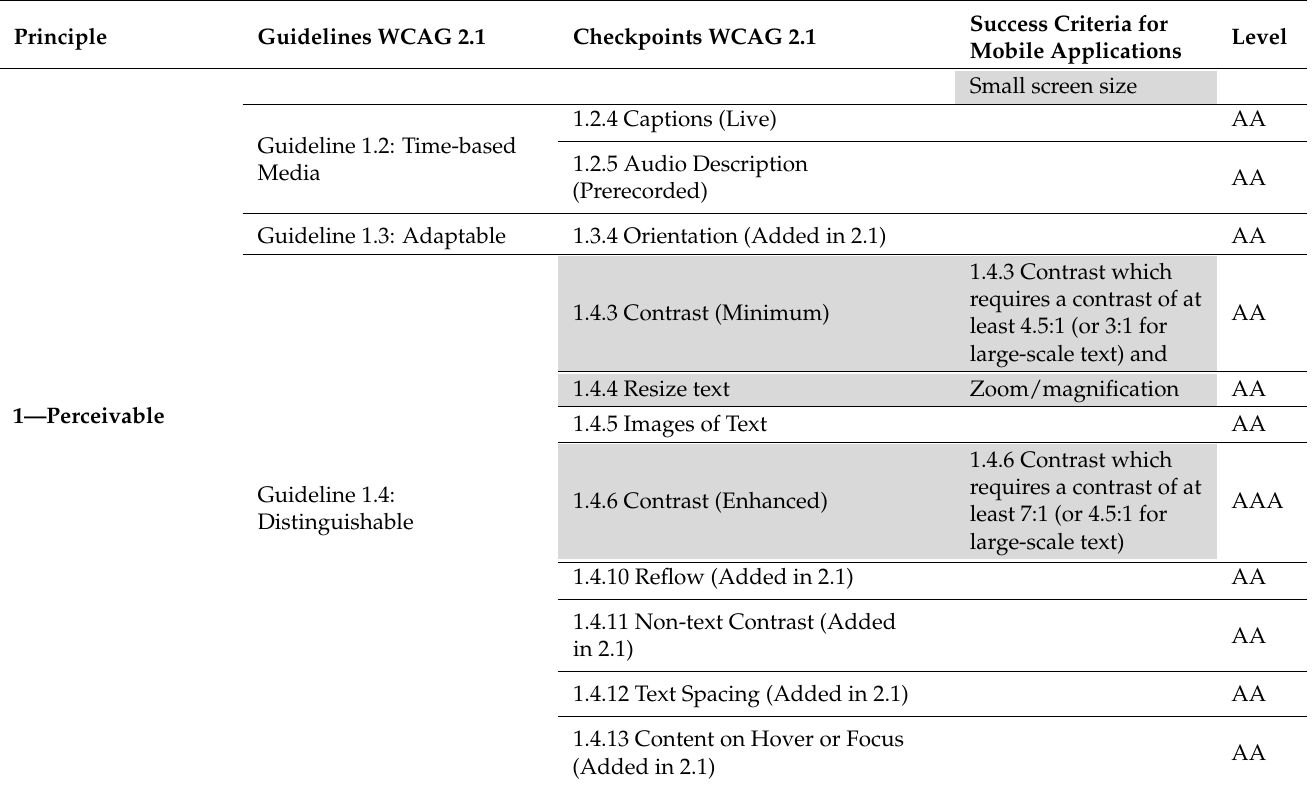
Table A7. Web Content Accessibility Guidelines 2.1 (level double A and triple A) and other W3C/WAI Guidelines apply to